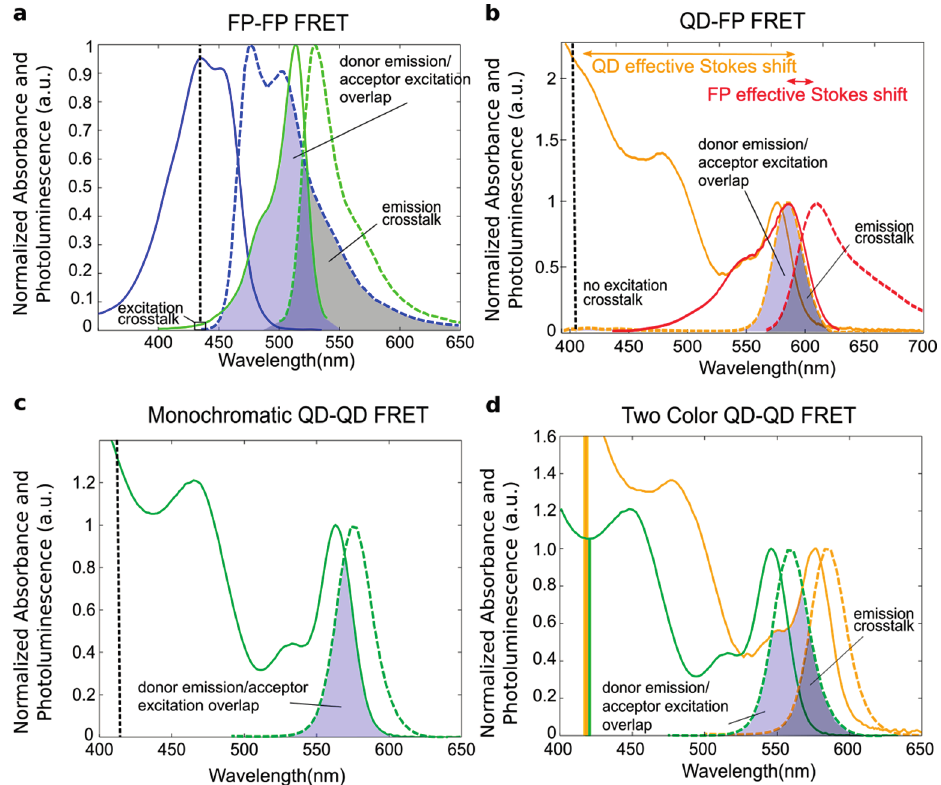
Figure 4. Normalized excitation and emission spectra of four different FRET pairs with schematized spectral overlaps shown. ( a ) Enhanced cyan fluorescent protein (ECFP, blue, donor) and enhanced yellow fluorescent protein (EYFP, green, acceptor); ( b ) A 3.7 nm CdSe/ZnS QD (orange, donor) and the fluorescent protein mCherry (red, acceptor); ( c ) A 3.3 nm diameter CdSe/ZnS QD acting as both donor and acceptor; ( d ) A 2.9 nm diameter CdSe/ZnS QD (green, donor) and 3.7 nm diameter CdSe/ZnS QD (yellow, acceptor). The vertical dotted black line in (a,b,c) indicates the expected excitation wavelength with the box indicating excitation crosstalk ( i.e. , where both the donor and the acceptor absorb the excitation light); In (d), the excitation crosstalk is represented with yellow and green bars, demonstrating that the acceptor has a significantly larger absorption than the donor, making excitation crosstalk a significant issue. The spectral overlap between the donor emission and acceptor excitation is shaded blue; the emission crosstalk ( i.e. , overlap between the donor and acceptor emission) is shaded grey. (a,b) were made using FP spectral data from